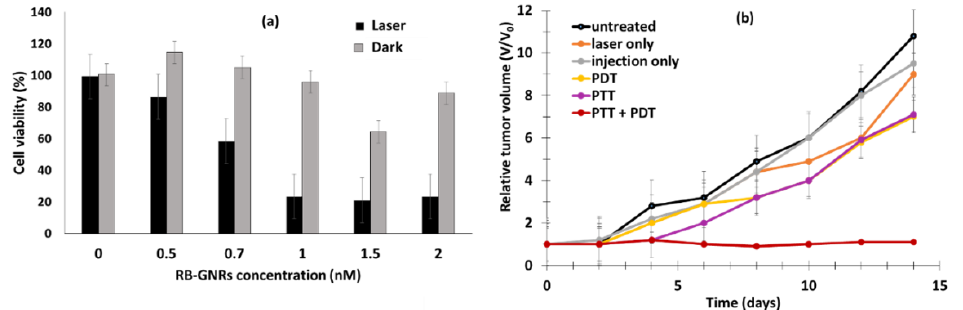
Figure 34. ( a ) CaI-27 cell viability in the dark or upon exposure to green laser light irradiation (532 nm, 1.76. W/cm 2 , 10 min). ( b ) Relative tumor volume under different treatment conditions (PDT: 532 nm, 1.76 W/cm 2 , 10 min; PTT: 810 nm 8.16 W/cm 2 , 5 min). Adapted from Wang et al. [83]. Prasanna et al. [84] designed glutathione (GSH)-capped gold NPs. RB was covalently attached via an amide bond between RB and GSH with EADC (1-Ethyl-3-(3-dimethylaminopropyl)carbodiimide) (Figure 35) or non-covalently coupled via electrostatic interactions.